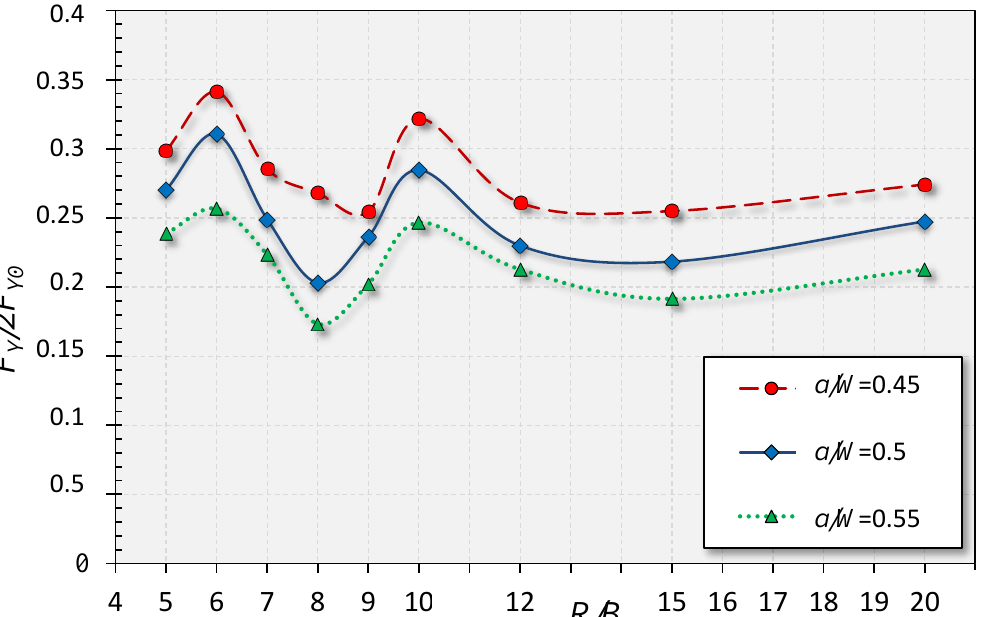
Figure 13. Obtained values of the limit load for all geometries from 5 to 20 and a crack or notch depth a / W in relation to the limit load of the same geometry in a solid section ring [4–7].